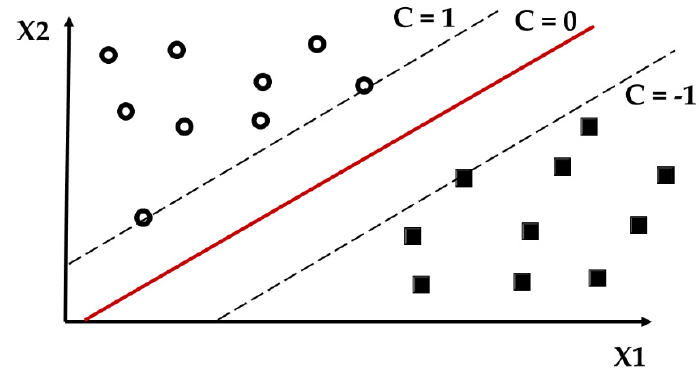
Figure 2. Illustration of the linear SVM.